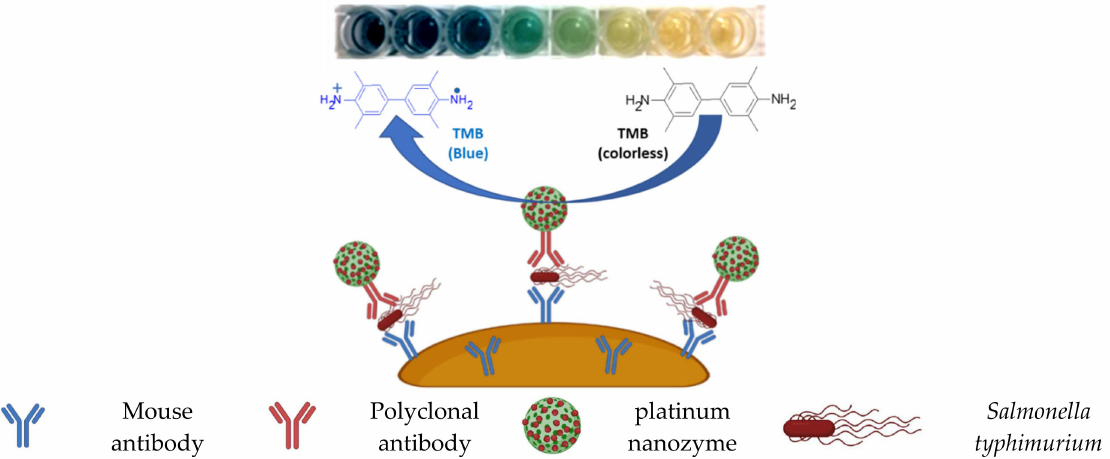
Figure 9. Colorimetric detection and quantification of Salmonella typhimurium (redrawn from Hu et al., 2021).